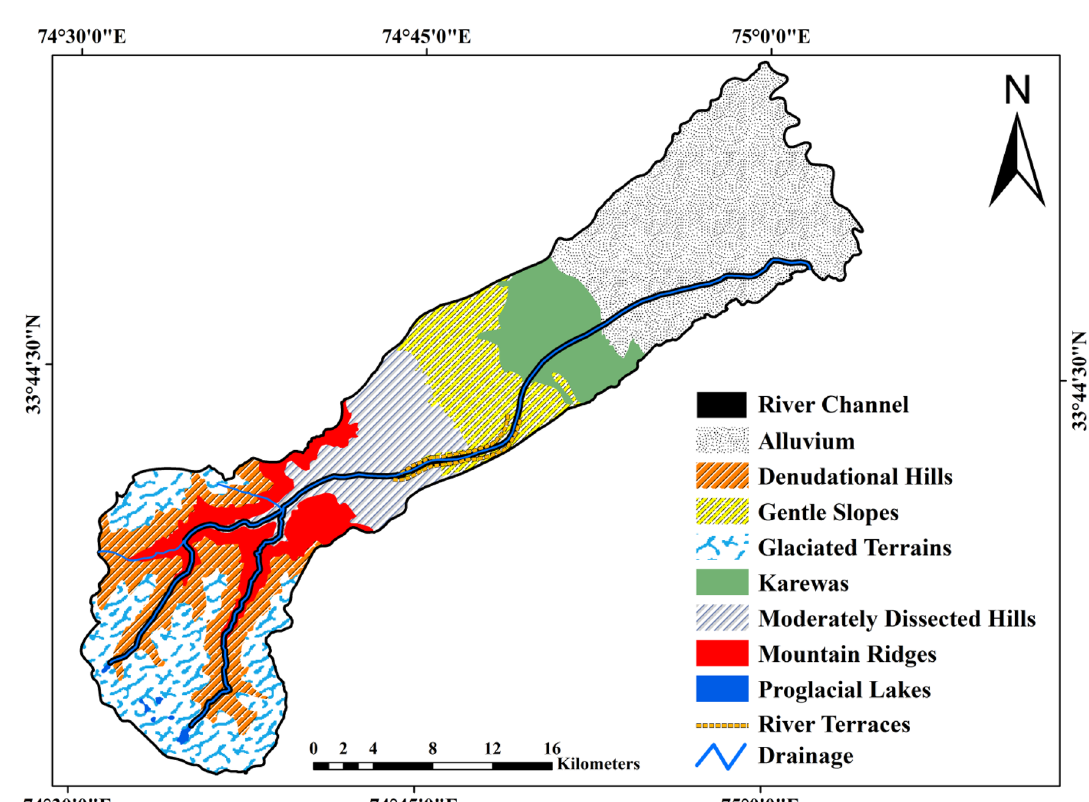
Fig. 2 Geomorphology of the study